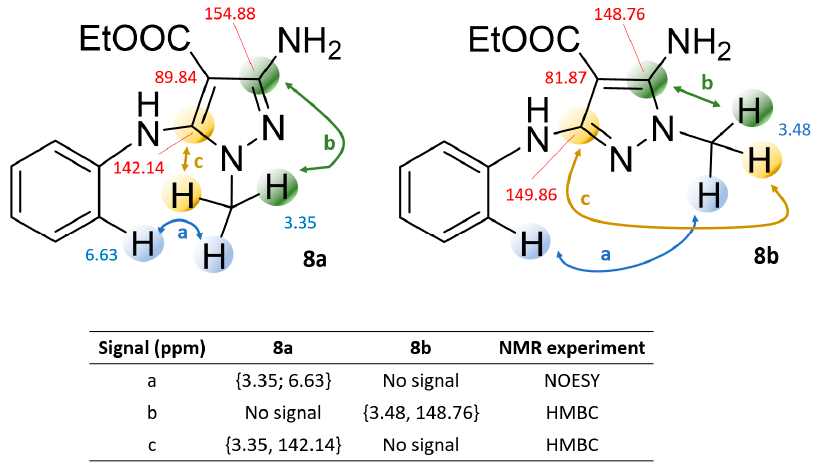
Figure 1. Relevant NMR couplings observed in NOESY and HMBC spectra of 8 regio-isomers. The interacting nuclei are differently colored, and the different interactions are indicated by double- headed arrows. The relevant chemical shift values are reported in red (carbon atom) and blue (proton